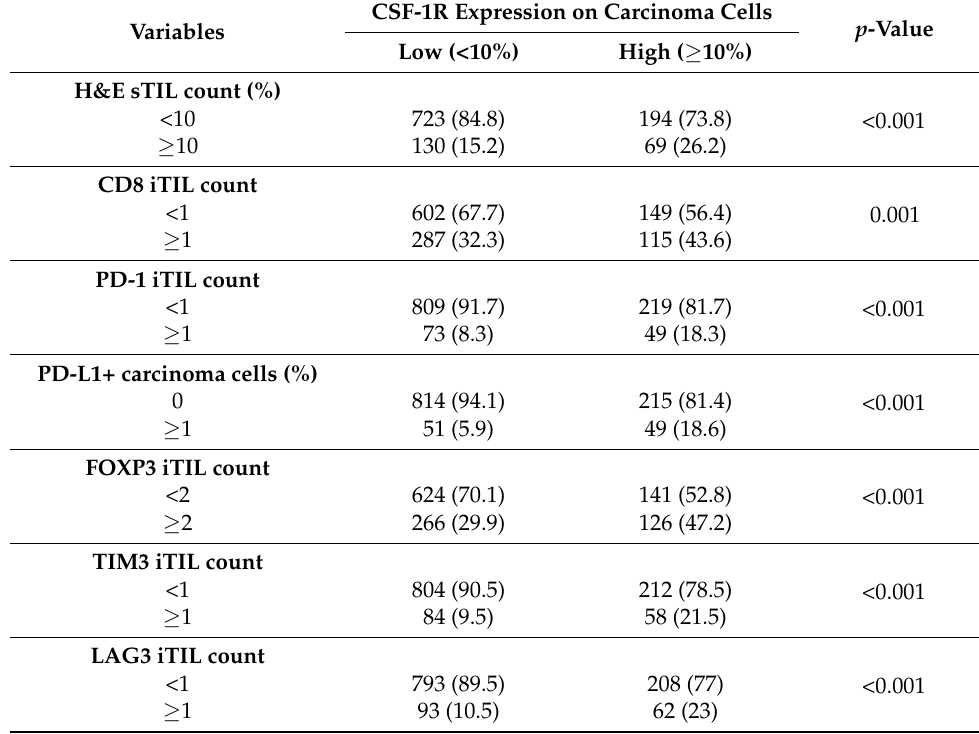
Table 2. Validation set of BC Cancer cohort: correlation of CSF-1R+ carcinoma cells with immune